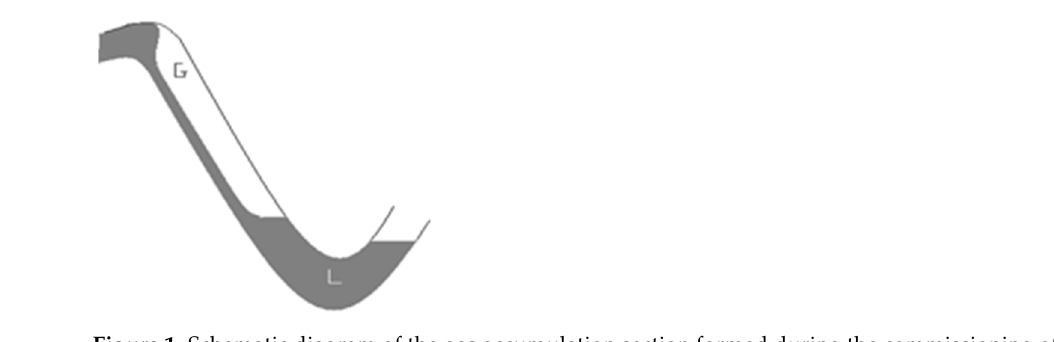
Figure 1. Schematic diagram of the gas accumulation section formed during the commissioning of a large-drop pipeline.